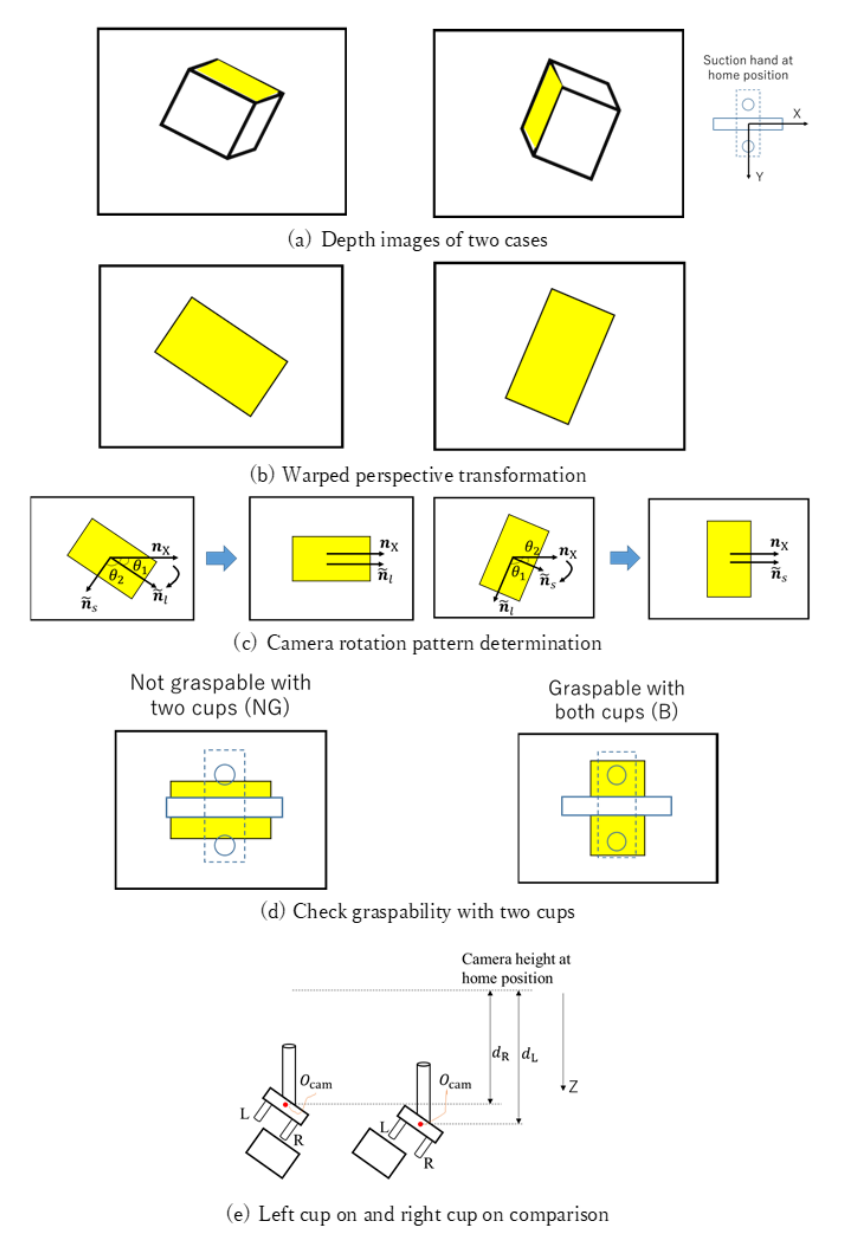
Figure 6. Examples of hand-level class labeling for two depth images. ( a ) Two cases of depth images. X is the camera long axis. ( b ) Warped perspective transformation. ( c ) Camera rotation pattern determination. ( d ) Check graspability with two cups. ( e ) Left cup on and right cup on comparison. O cam is the camera center when picking the object. d R and d L are the distance between O cam and the camera center at the home position along camera axis Z when picking the object by the corresponding